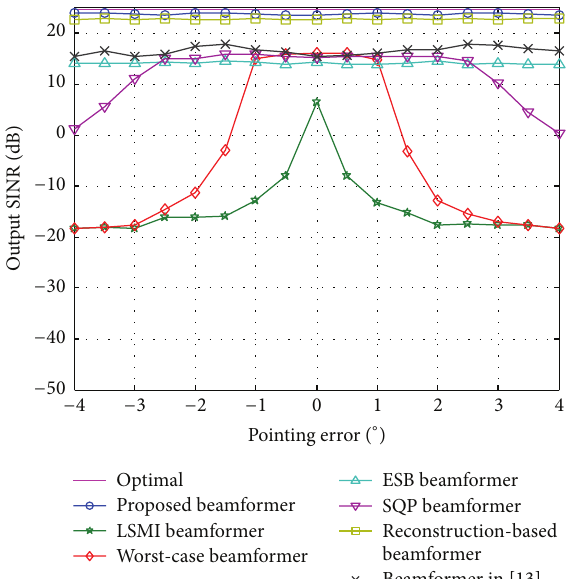
Figure 3: Output SINR versus pointing error for training data size of 𝐾 = 60 and SNR = 10 dB and INR = 30